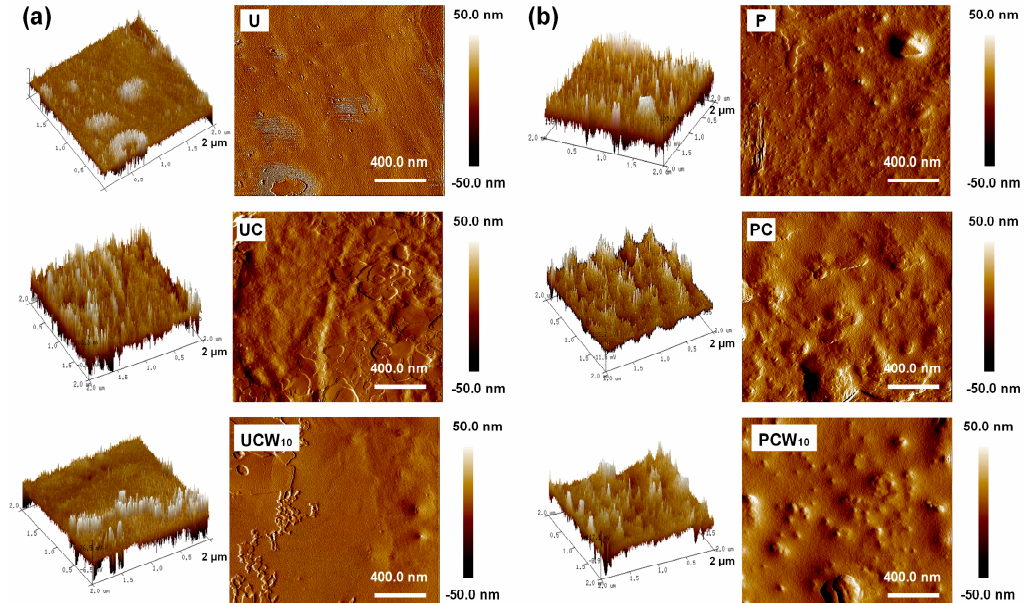
Figure 1. Atomic Force Microscopy (AFM) images of aramid fabric after various treating, coating, and washing processes. ( a ) Untreated (U), untreated phosphorus–fluoride coating (UC), and UC with 10 washing cycles (UCW 10 ); ( b ) plasma-treated (P), plasma-treated coated (PC), and PC with 10 washing cycles (PCW 10 ).